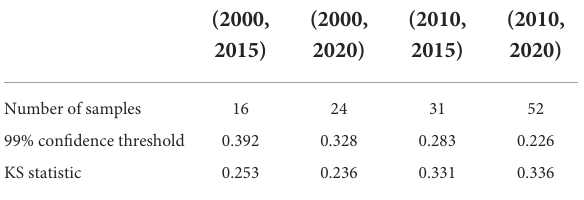
TABLE 5 KS test of Small impact type: the critical value of the KS statistic at 99% confidence and the KS statistic for each fixed time